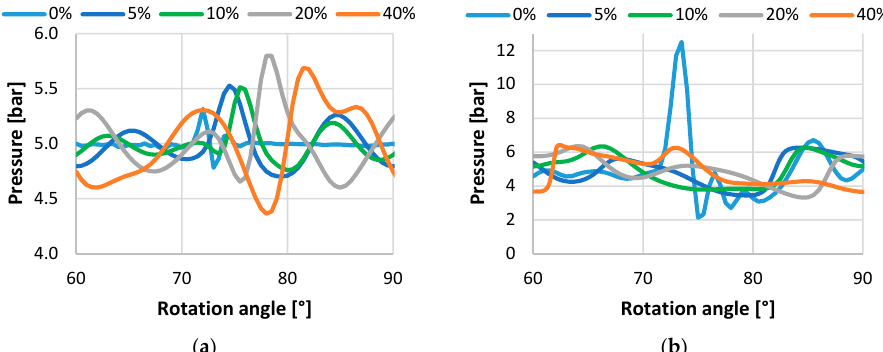
Figure 28. Influence of the IGVF of free air on the outlet 1 pressure ripple at 5-bar delivery pressure, ( a ) 1000 rpm and ( b ) 4000 rpm.